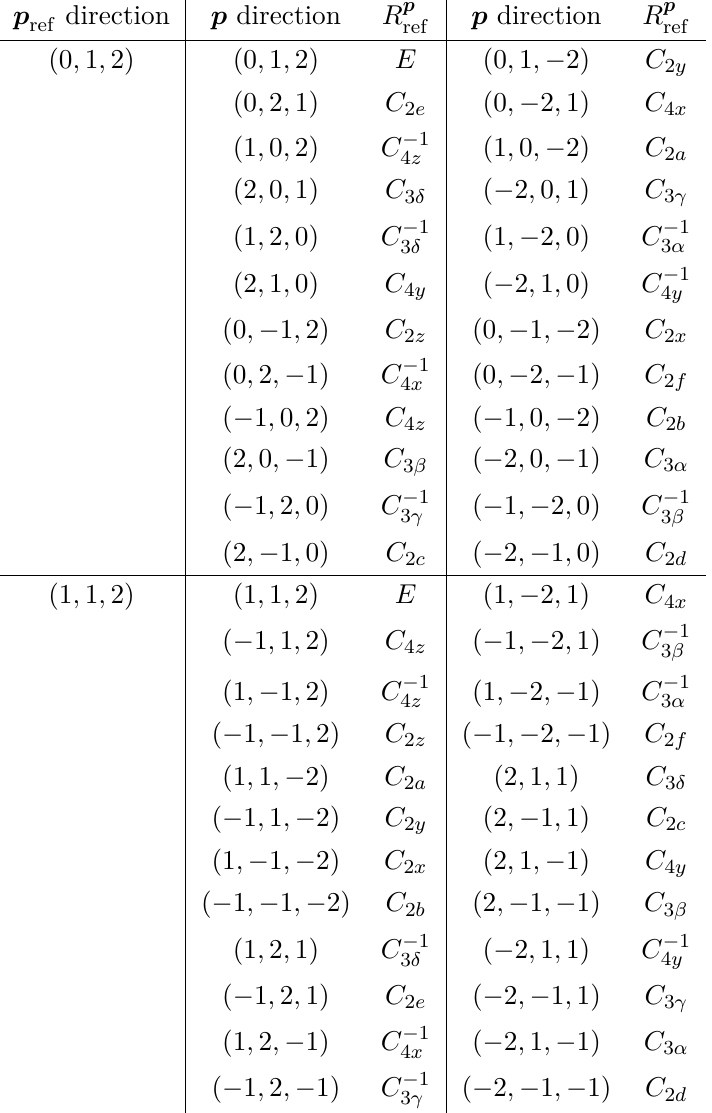
directions and the reference rotations R p ref ref